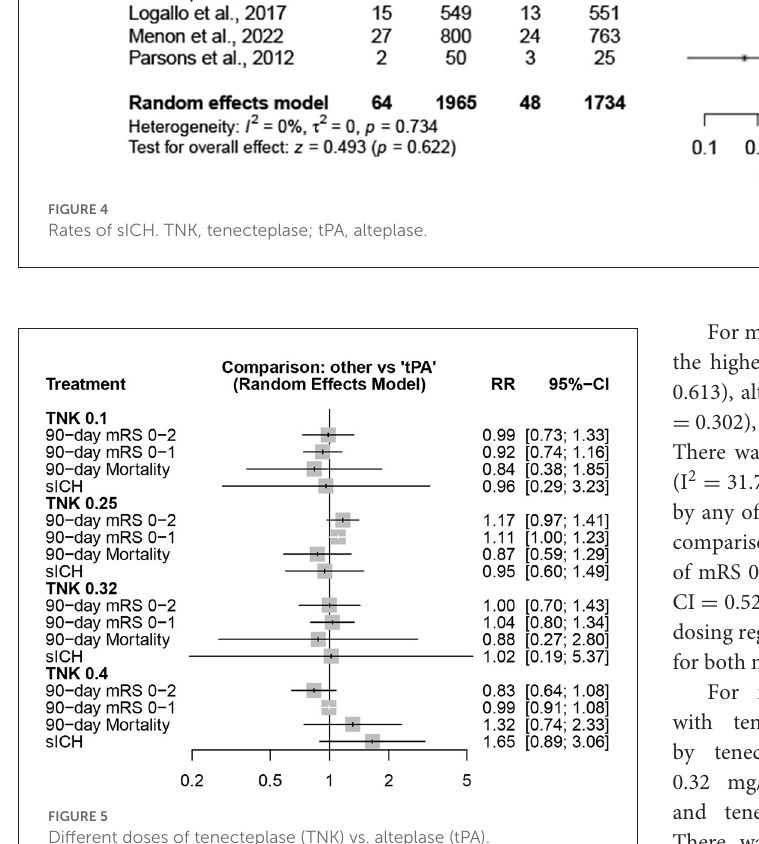
= 0.181) or sICH (I 2 = 0%; P -value = 0.734) rates (Figure 4).